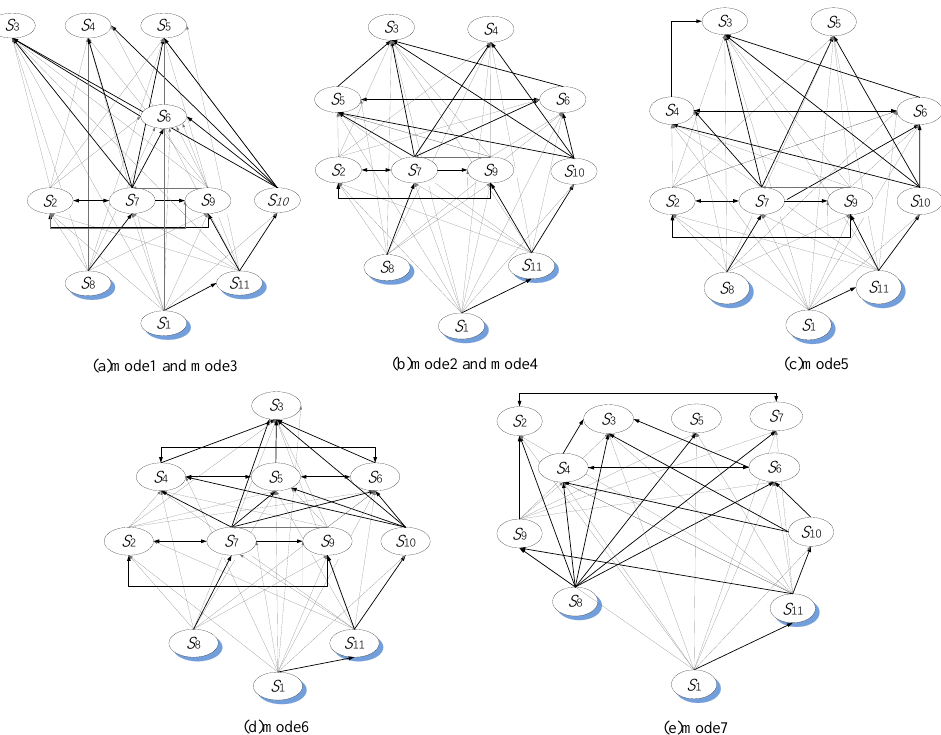
Figure 4. Organizational structure and influence relationships of the main controlling factors of the land-use modes of the dike–pond systems. Note: ( a – e ) represent the subfigures of Figure 4, and the solid lines with the arrow represent the relationships among the factors in the systems.